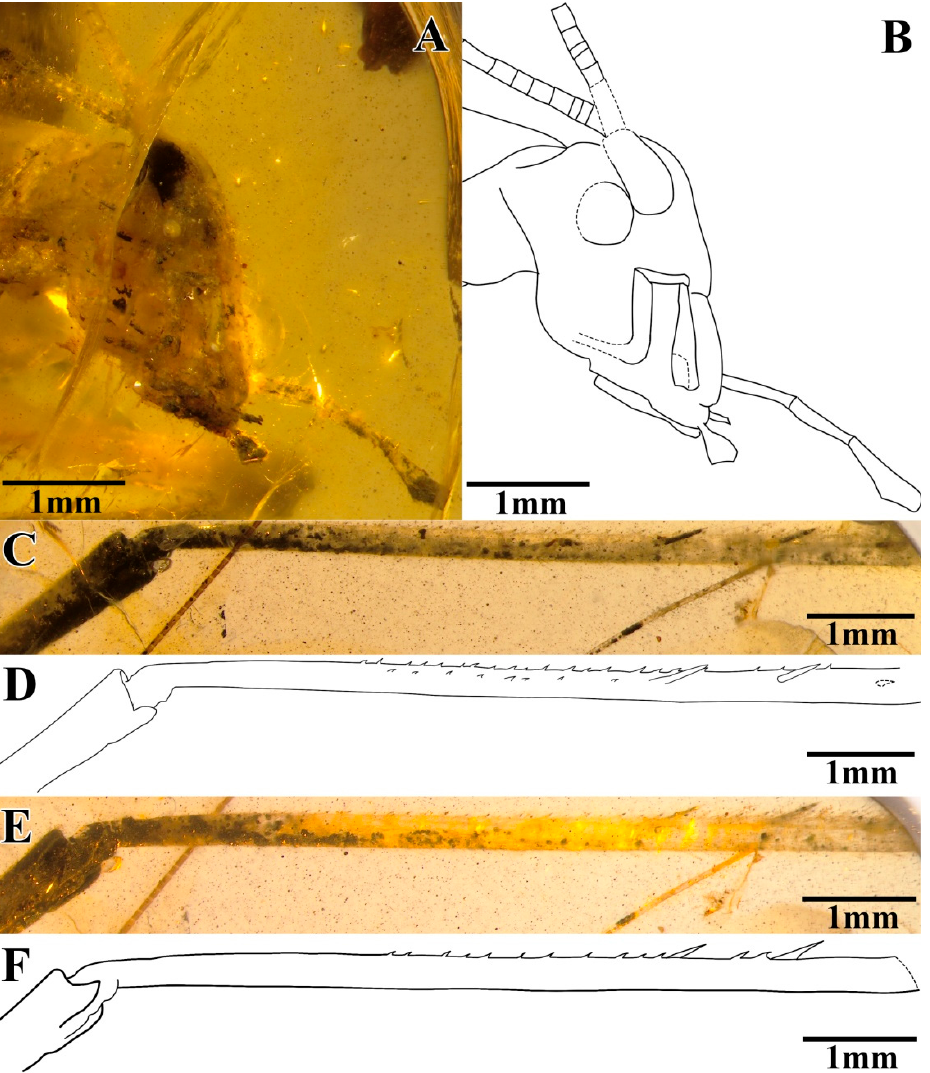
Figure 4. Details of A. cretaceus sp. nov.: ( A ) photograph of head, ( B ) line drawing of head, ( C ) pho- tograph of metatibia (inner side), ( D ) line drawing of metatibia (inner side), ( E ) photograph of metatibia (outer side), and ( F ) line drawing of metatibia (outer side).